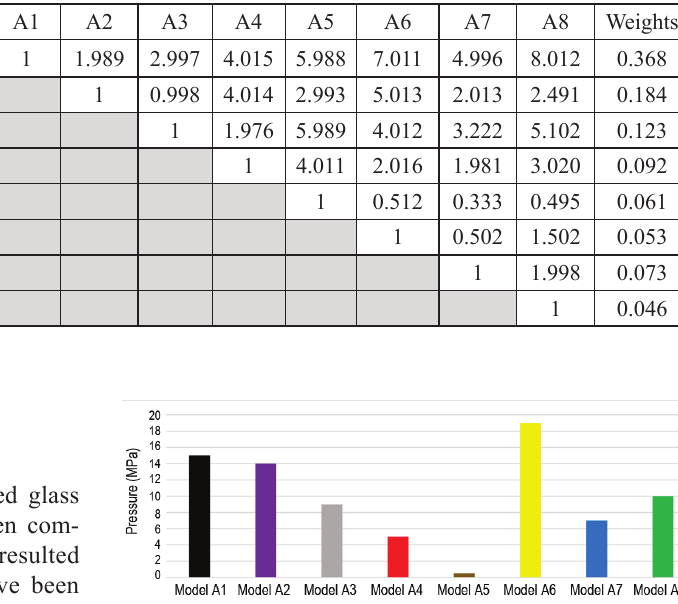
Fig. 8. Comparison chart of maximum quantities of occurred pressure for eight laminated glass models